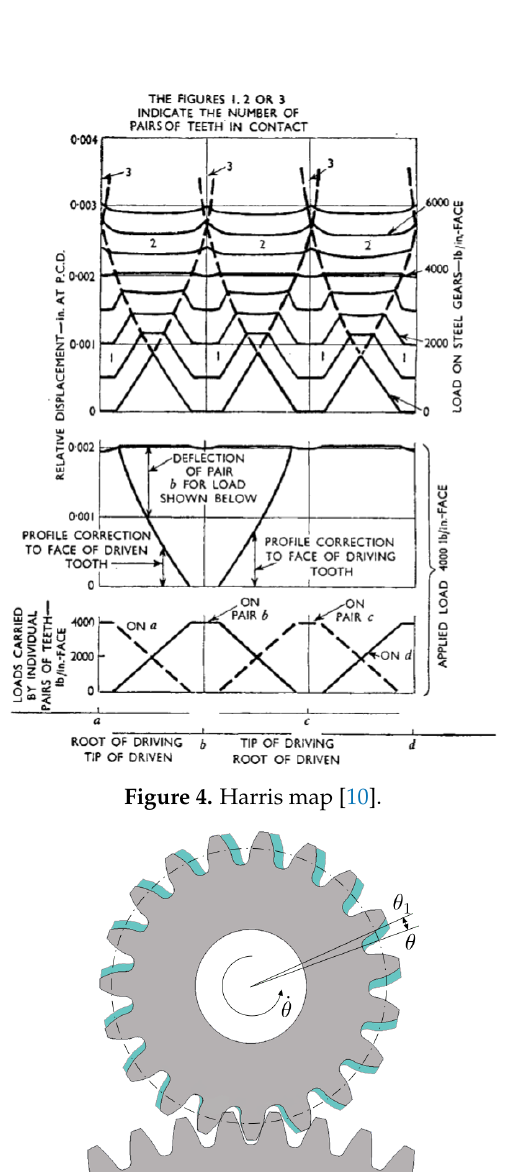
Figure 5. Visualization of TE: in grey the ideal position, in cyan the actual